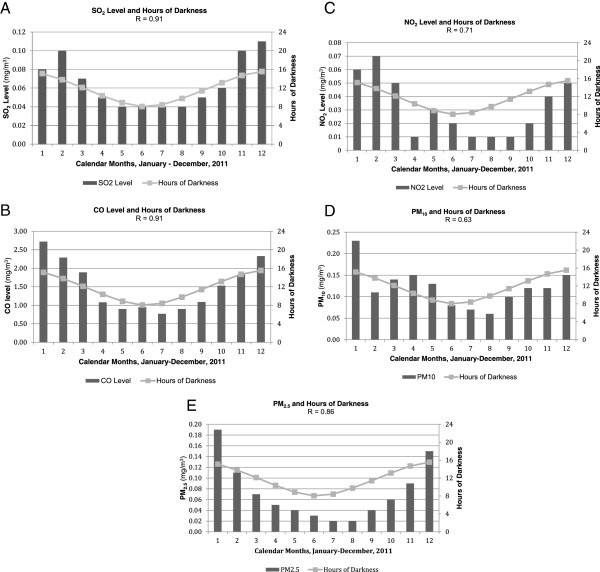
Calendar monthly averages of ambient air pollutant levels correlated with hours of darkness. (A) SO2. (B) CO. (C) NO2. (D) PM10.(E) PM2.5. Monthly average air pollutant levels are shown as black bars; seasonal hours of darkness during the annual solar cycle of 2011 are shown as grey dots and a connecting line.